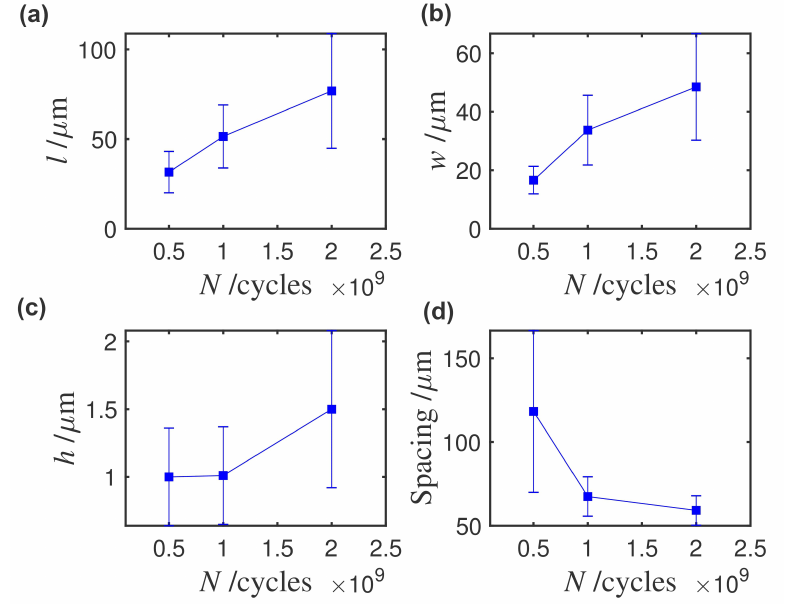
Figure 4. Statistical measurements of WEB length ( a ), width ( b ), thickness ( c ) and spacing ( d ) in the three samples. The error bars represent standard